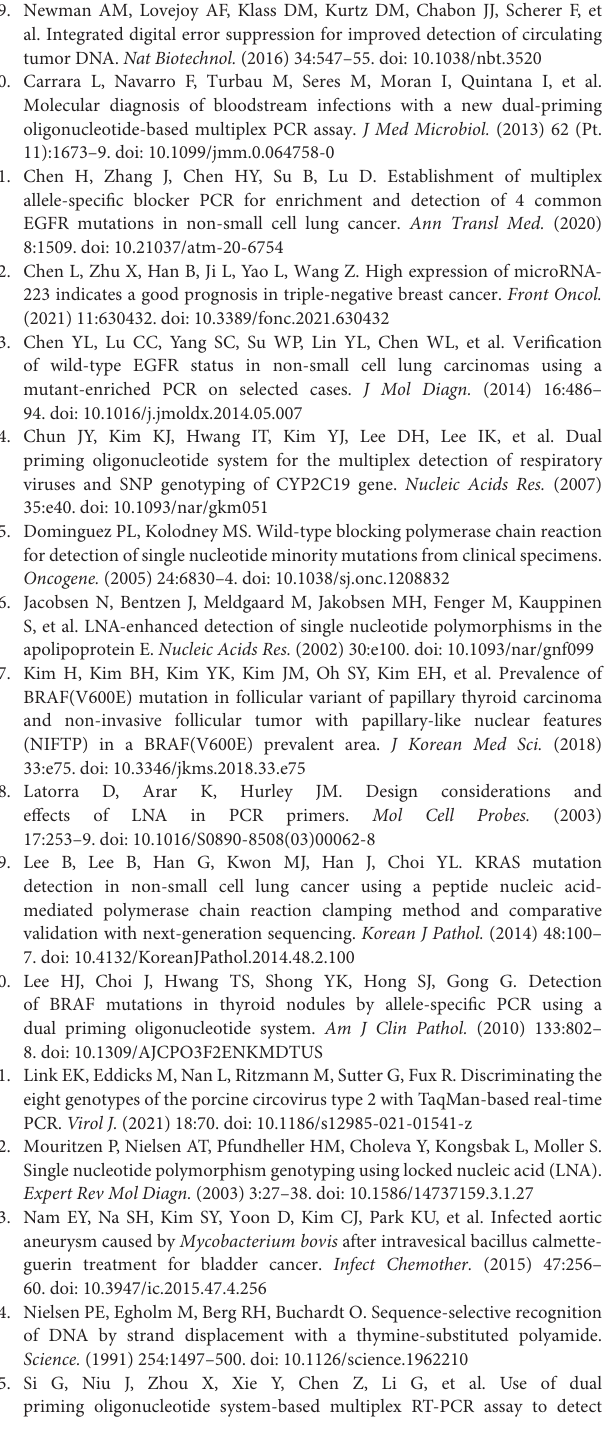
Supplementary Table 4 | The sequences of forward and reverse NGS primers, and their concentrations. Supplementary Table 5 | Overview of patient characteristics of three cohorts in this study.